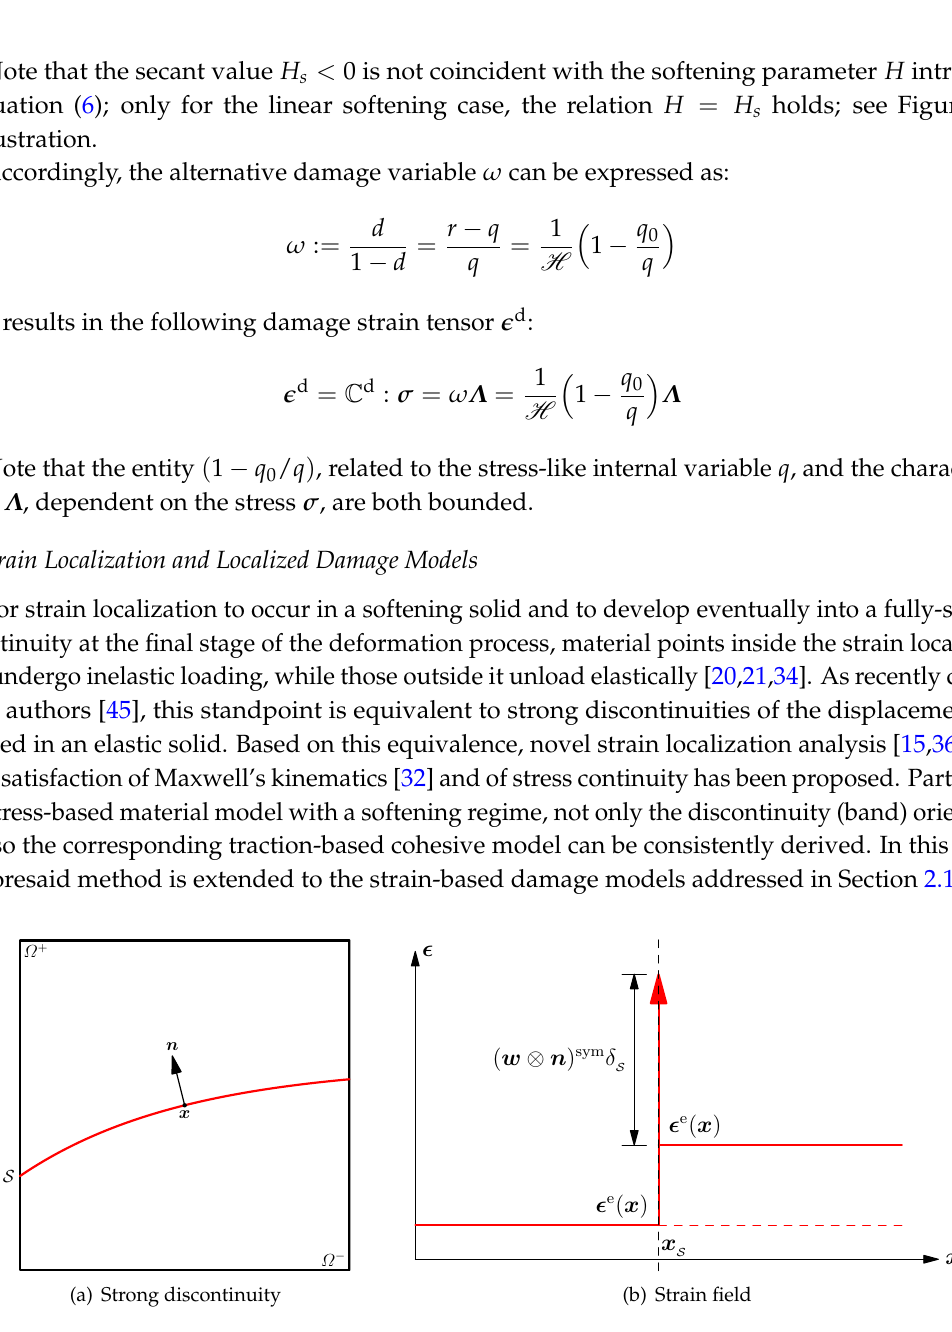
Figure 3. Strong discontinuity and the resulting singular strain field in an elastic